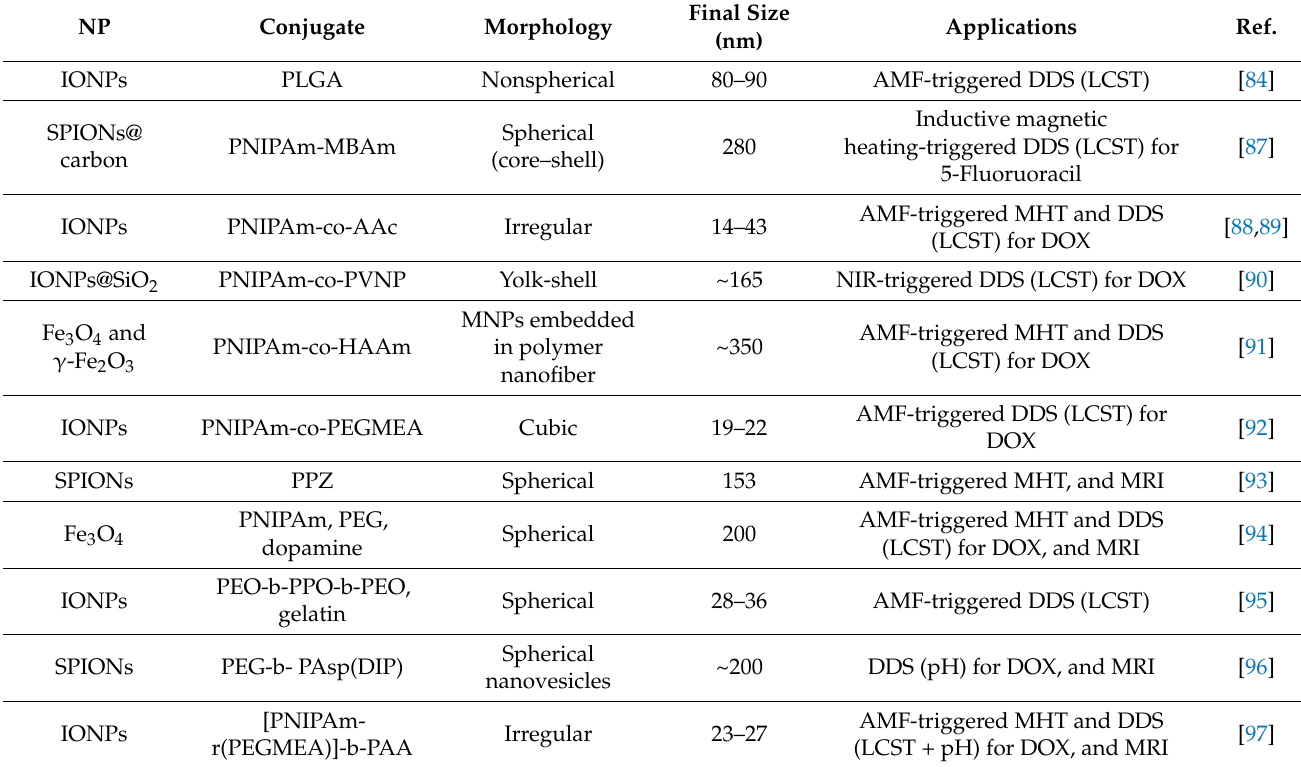
Table 5. Stimuli-responsive polymer-integrated magnetic NPs for biomedical